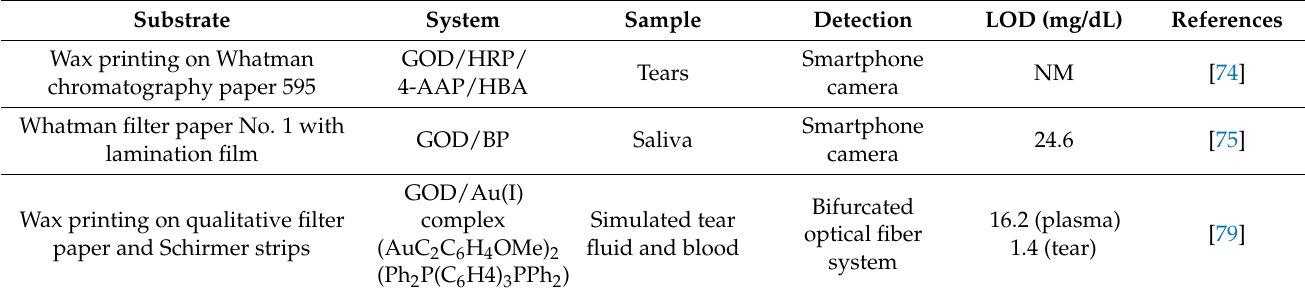
Table 1. Summary of reported enzymatic paper-based platforms in representative references.